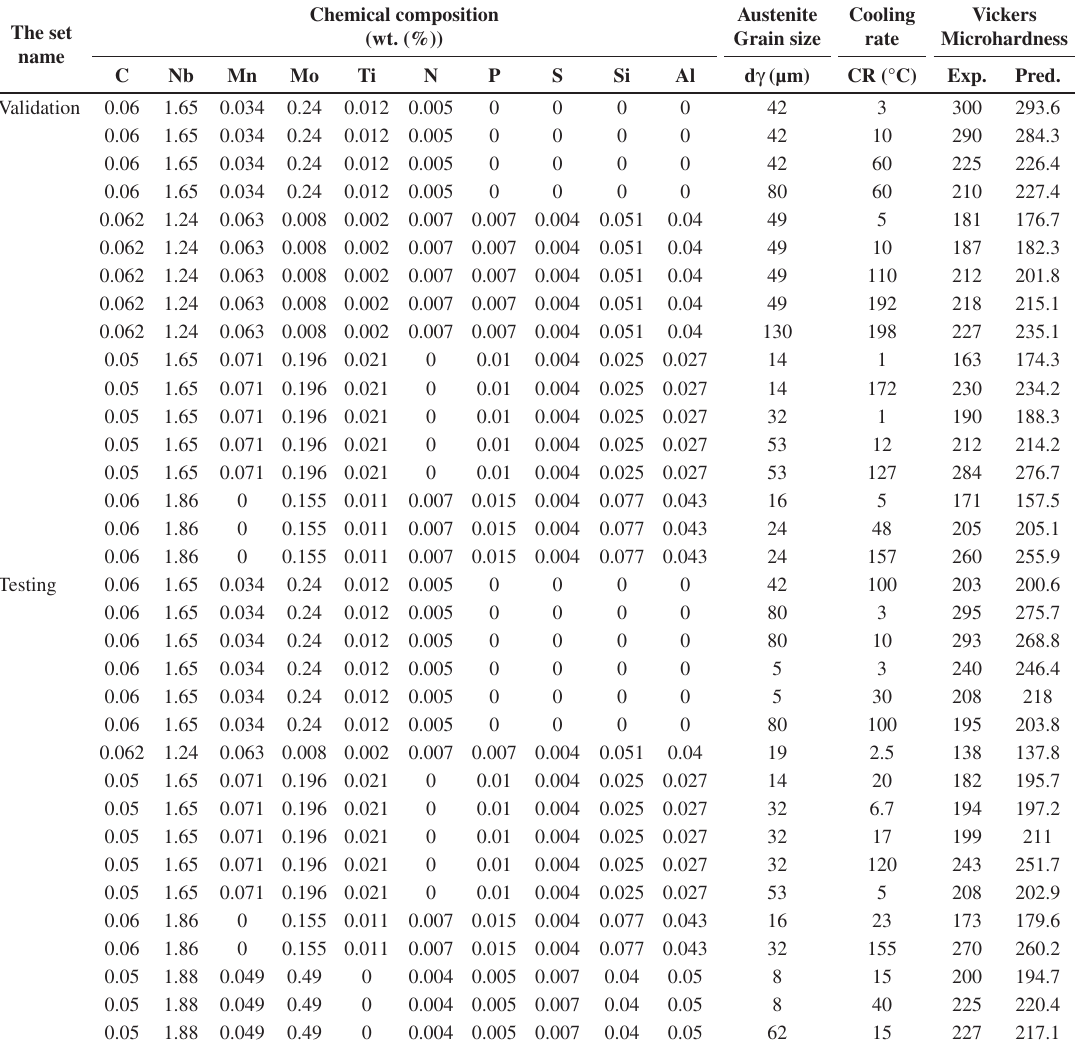
Chemical composition (wt.